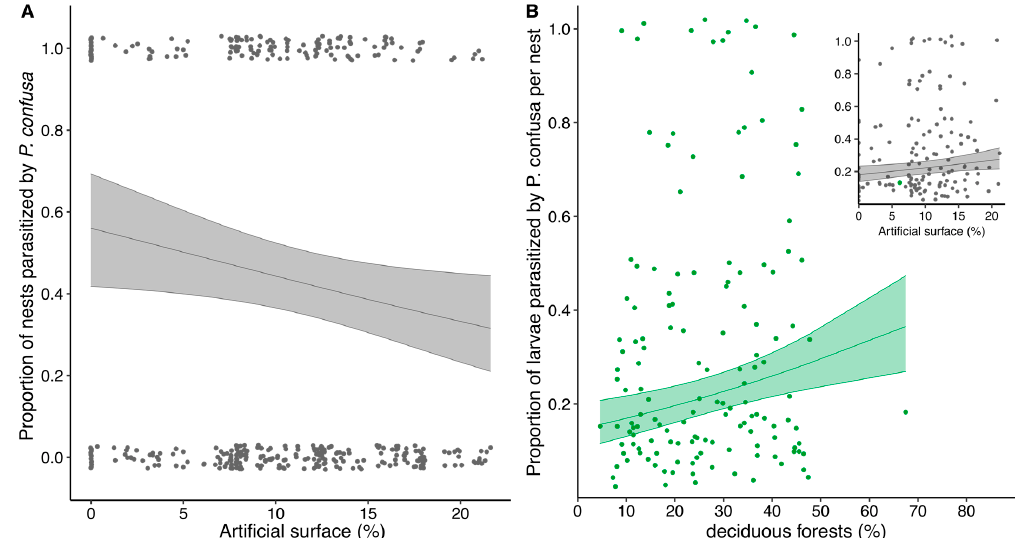
Figure 3. ( A ) Proportion of nests parasitized according to the proportion of artificial surface within a bu ff er zone of 100 m radius and ( B ) proportion of larvae parasitized by P. confusa per nest according to the proportion of deciduous forests and artificial surface within a bu ff er zone of 100 m radius. Dots correspond to the raw data (jittered in A ), means ± confidence intervals correspond to the estimated marginal means from the